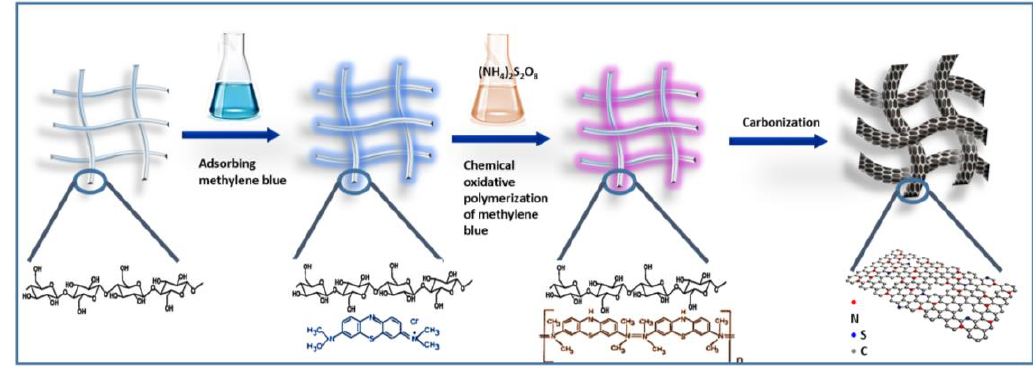
Figure 1. Synthetic procedure of the N/S-CNF.